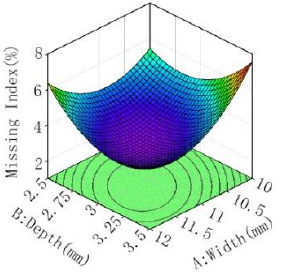
Figure 16. The impact of interaction factors on the miss index.